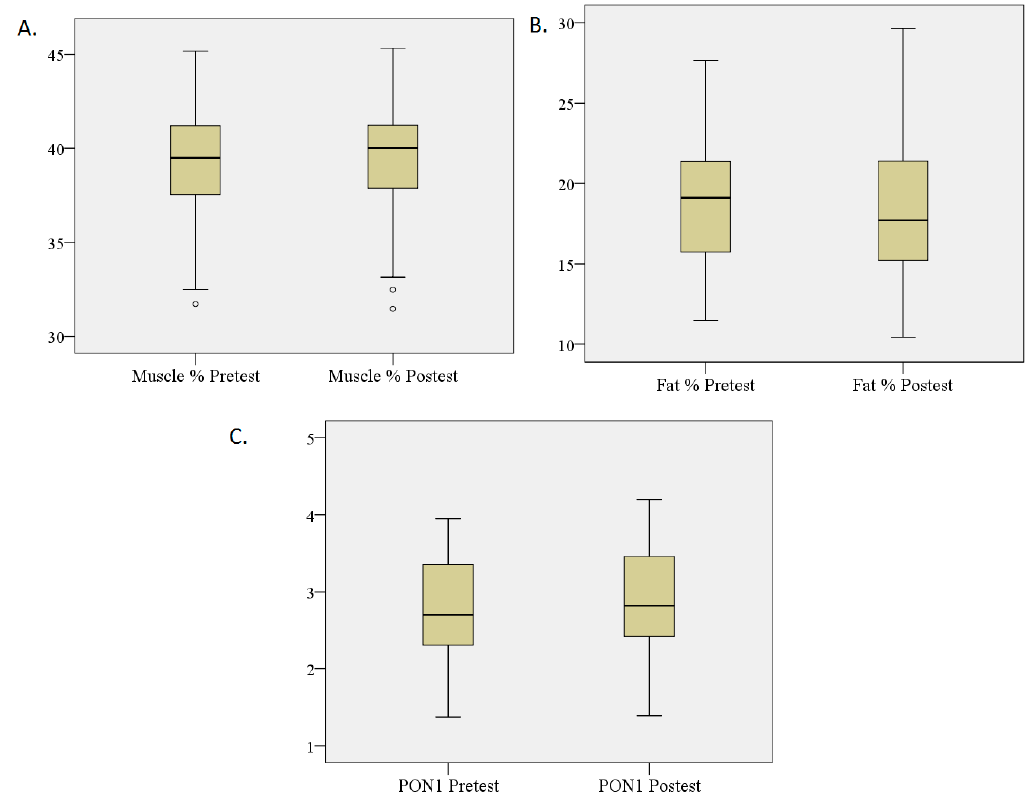
Figure 1. Changes in muscle and fat percentage and PON1 (paraoxonase 1) levels in serum. ( A ) N = 27; Body composition measurements were taken using the Faulkner method; Wilcoxon signed-rank test showed a significant increase in muscle mass ( p = 0.003). ( B ) N = 27; Body composition measurements were taken using the Faulkner method; Wilcoxon signed-rank test showed a significant decrease in fat mass ( p = 0.000). ( C ) N = 27; The PON1 activity was measured by using 4-Nitrophenyl acetate; Wilcoxon signed-rank test showed a significant increase in PON1 ( p = 0.000).